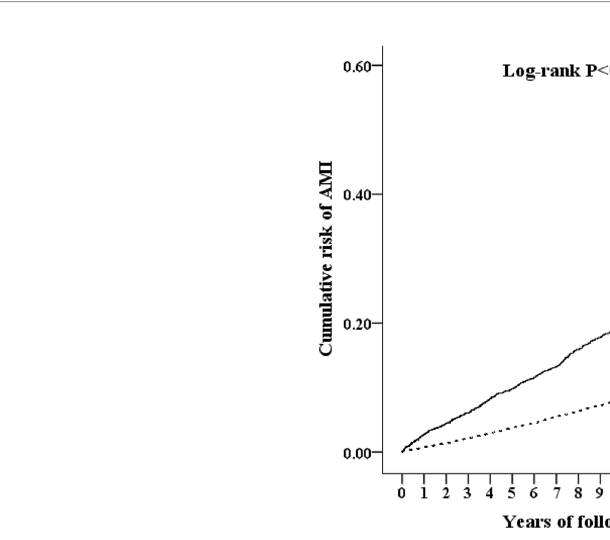
FIGURE 2 | Kaplan-Meier analysis of the cumulative risk of AMI, strati fi ed by uveitis with log-rank test. AMI, acute myocardial